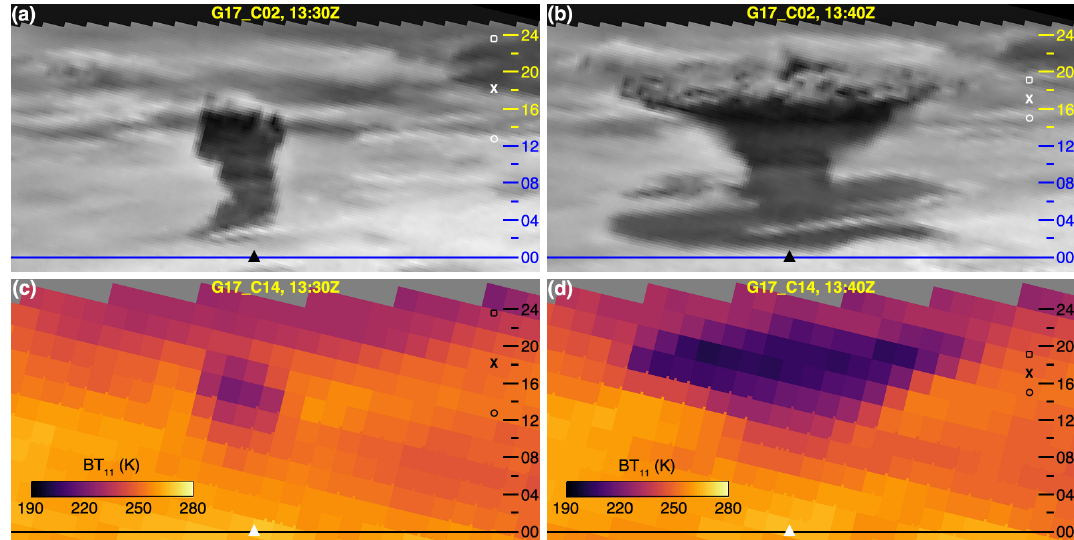
Figure 11. The eruption plume on 11 April 2021 at (a, c) 13:30UTC and (b, d) 13:40UTC in GOES-17 imagery: (a, b) channel 2 and (c, d) channel 14, with elevation markings as in Fig. 5.